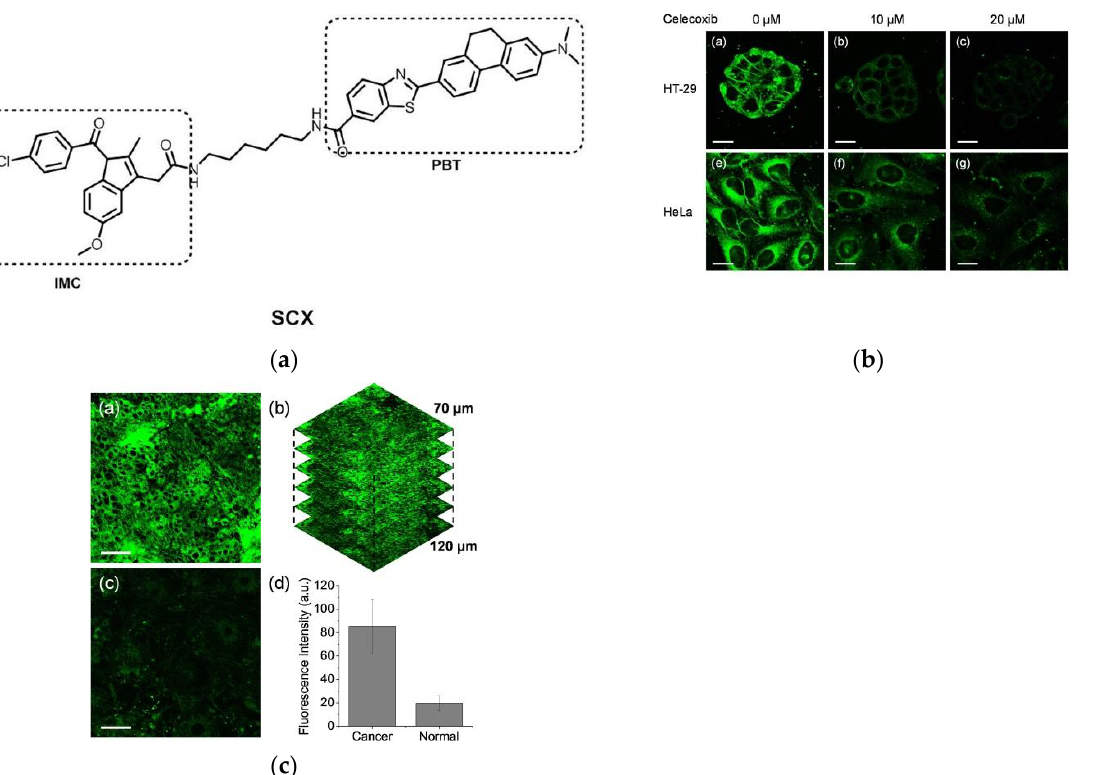
Figure 4. ( a ) Structure of probe SCX; ( b ) Two-photon fluorescence images of cells; ( c ) Two-photon fluorescence images of human colon ( c-a ) cancer tissues and ( c-c ) normal tissues. Reproduced with permission from [41]. Copyright 2020 Elsevier B.V.